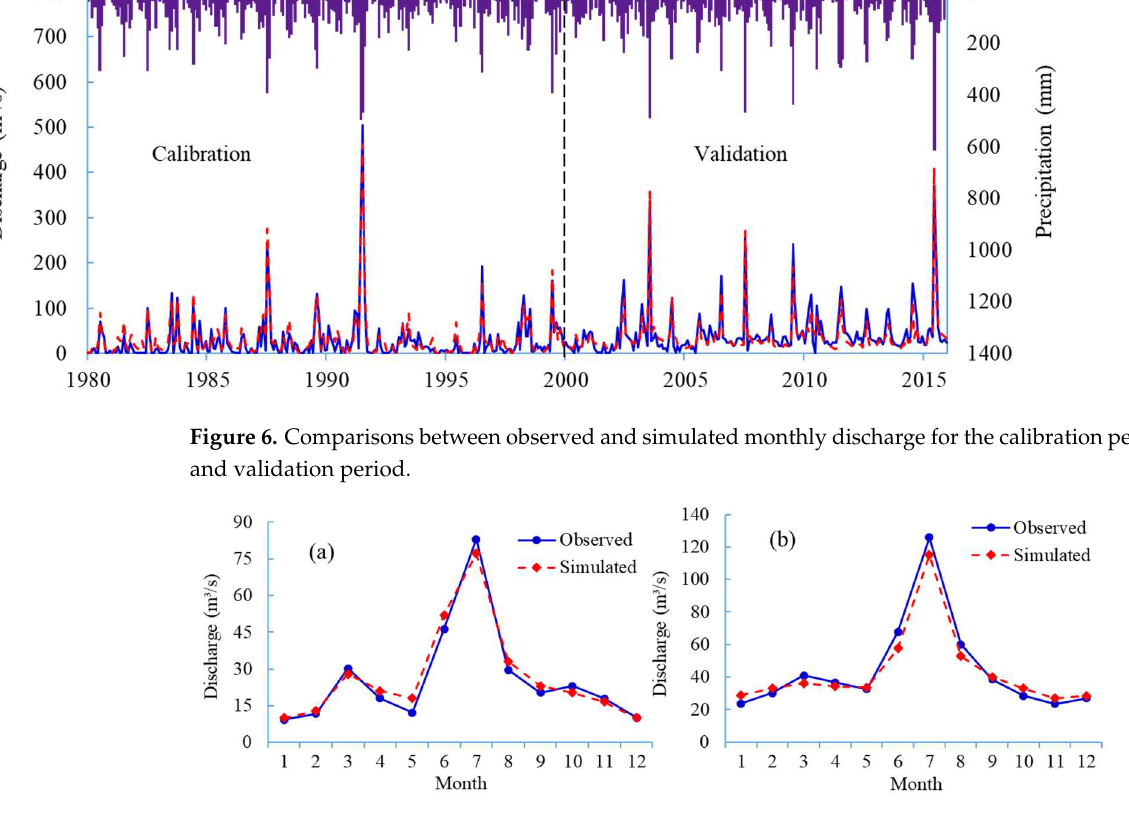
Figure 4. The daily simulated and observed discharges for the typical years (a and b indicate 2000 and 2010).